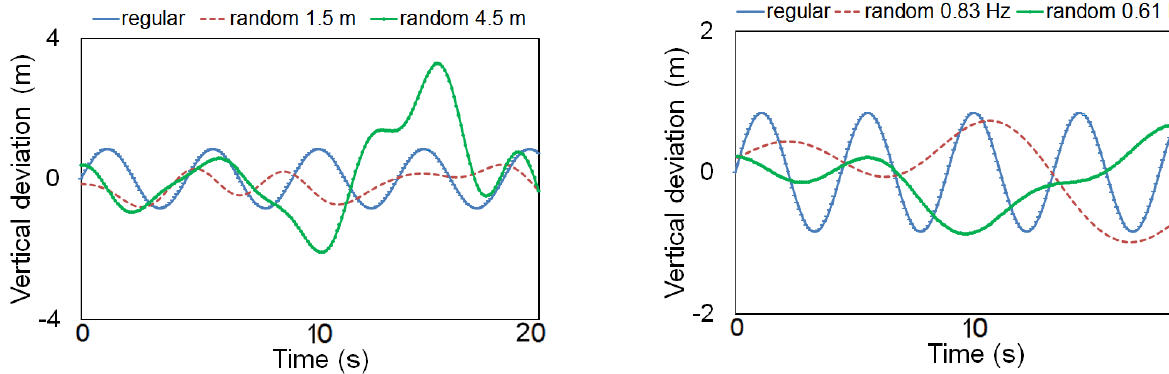
Figure 14. Floater vertical deviations resulted from a regular wave compared to random waves with different significant wave height-equal peak frequency ( left ), and to random waves with different peak frequency-equal significant wave height ( right ).